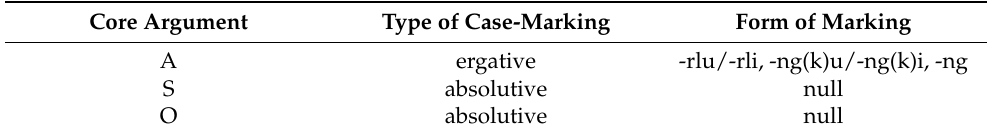
Table 3. Core arguments and case-marking in Warlpiri. Type of